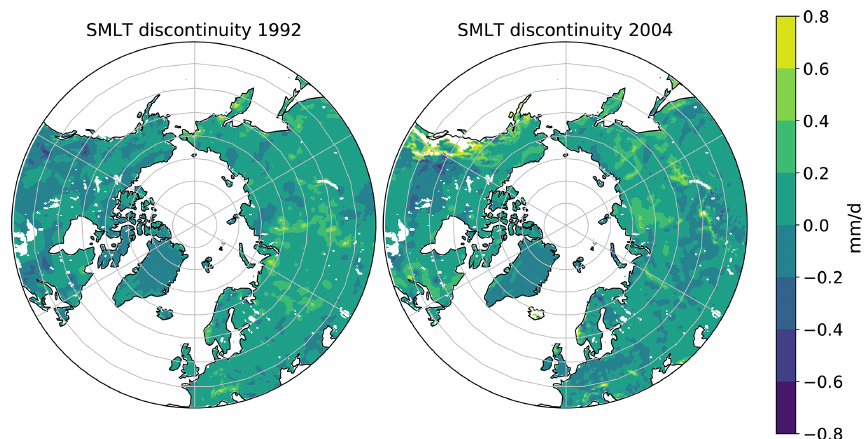
Figure 8. ERA5 snowmelt discontinuities, calculated by subtracting the long-term SMLT means from 1979–1991 and 1992–2003 and respectively 1992–2003 and 2004–2019.